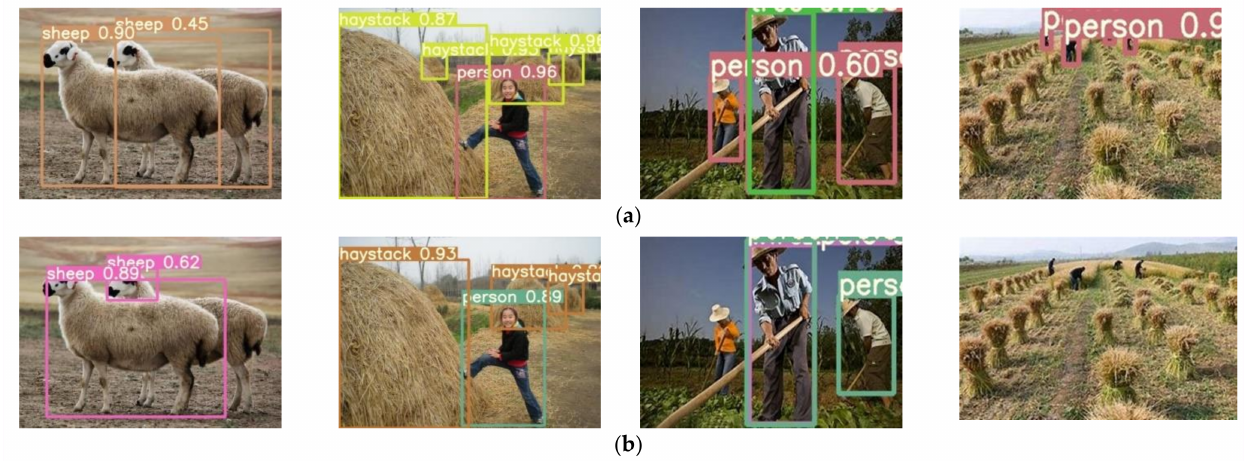
Figure 13. Comparison of detection effects of improved and original YOLOv5s. ( a ) detection effects of the improved YOLOv5s; ( b ) detection effects of the original YOLOv5s.